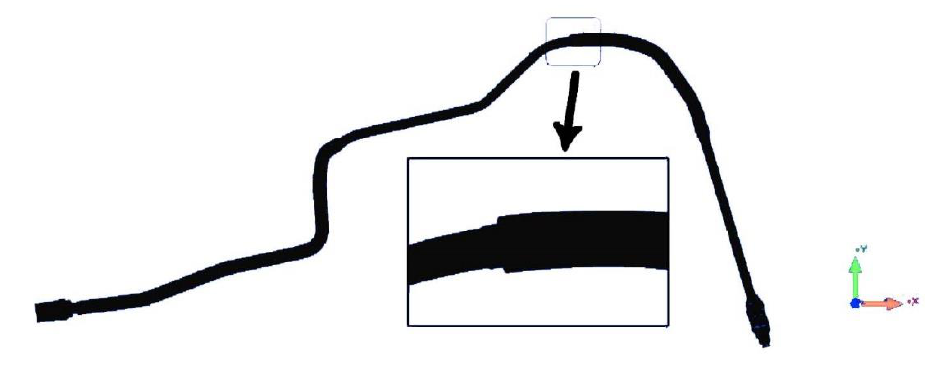
Figure 14. Tube reconstruction result.